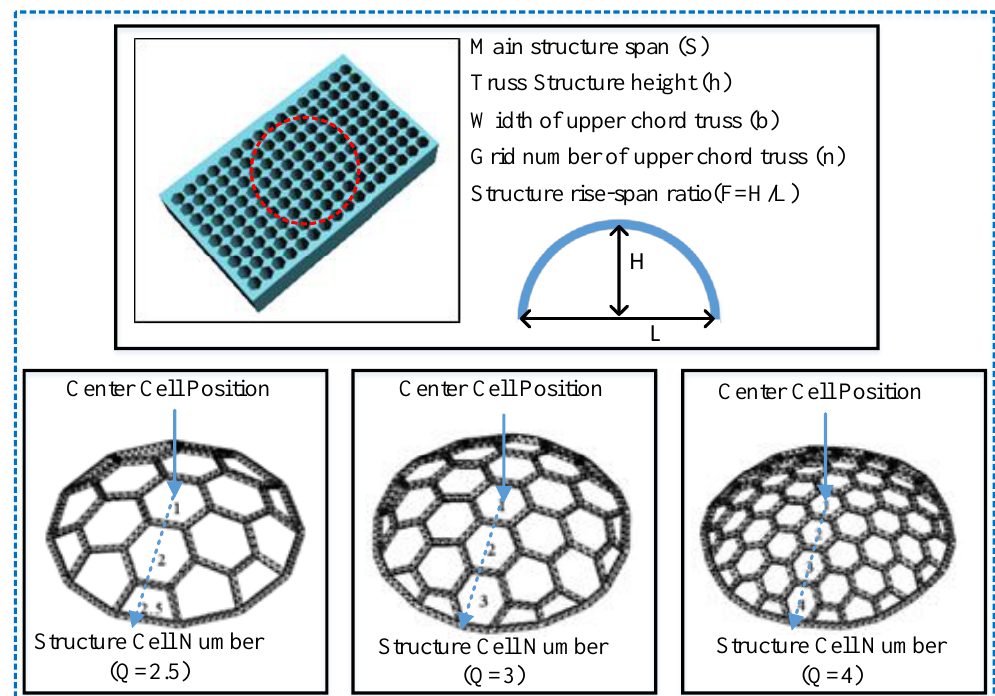
Figure 3. Honeycomb structure and related parameters .